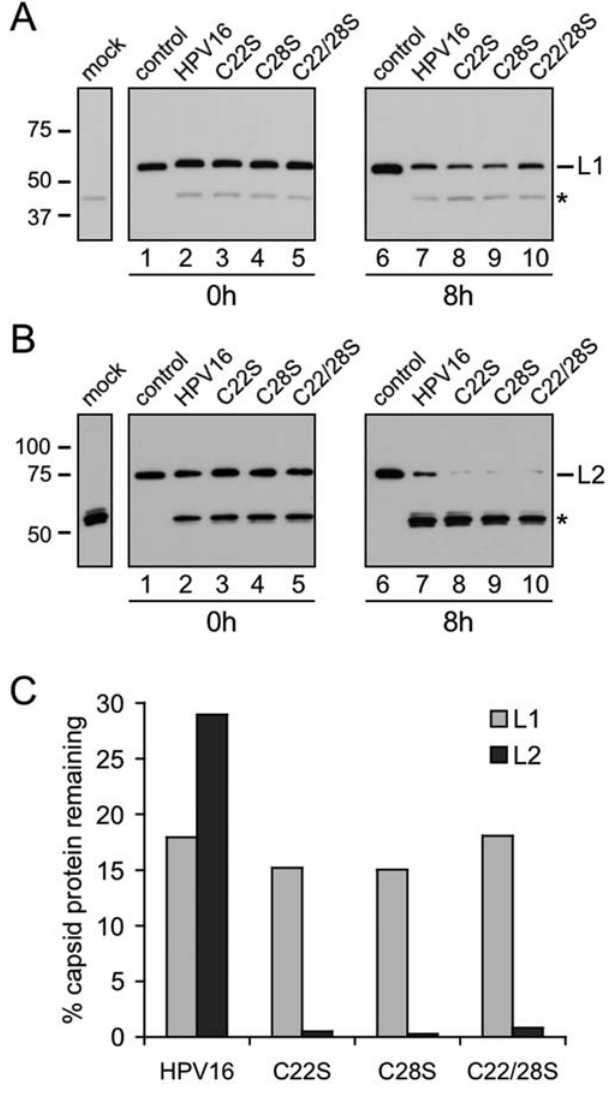
Figure 6. Degradation of wild type and L2 mutant virions during infection. Total cell lysates of infected HaCaT cells were collected at 0 h and 8 h post infection. Lysates were separated by SDS- PAGE and immunoblotted for capsid proteins. (A) L1 immunoblot of mock treated and infected HaCaT cell lysate. (B) L2 immunoblot of mock treated and infected cell lysates. Control lanes contain a known amount of purified HPV16 for comparison across blots. Asterisks represent non-specific bands present in cell lysates. (C) Percentages of L1 (grey bars) and L2 (black bars) capsid proteins remaining after 8 h of intracellular trafficking was calculated by densitometry as described in materials and methods.